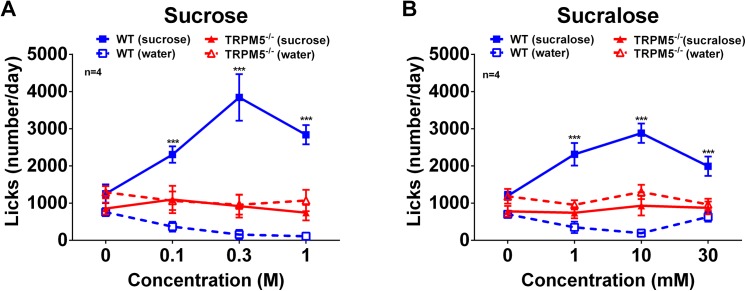

Trpm5
-/- mice do not have any acute preference for sweet taste.Acute two bottle taste preference test in male Trpm5
-/- and wild type mice under conditions of free access to water in one bottle and sweetener in the other. Average daily (16h, starting 3h before active period) number of licks of water and sucrose (A) or sucralose (B) for Trpm5
-/- and wild type mice. Data are presented as mean ± SEM, n = 4, *** p<0.001, water vs sweetener within the same genotype (Students t-test).